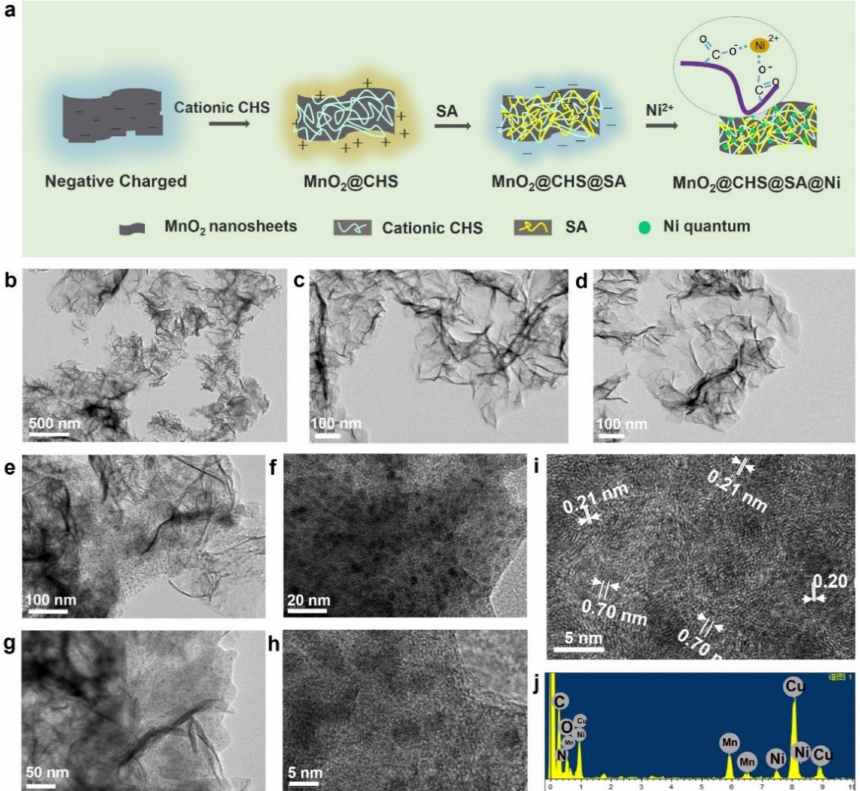
Figure 1. Schematic image of fabrication process and structure characterization